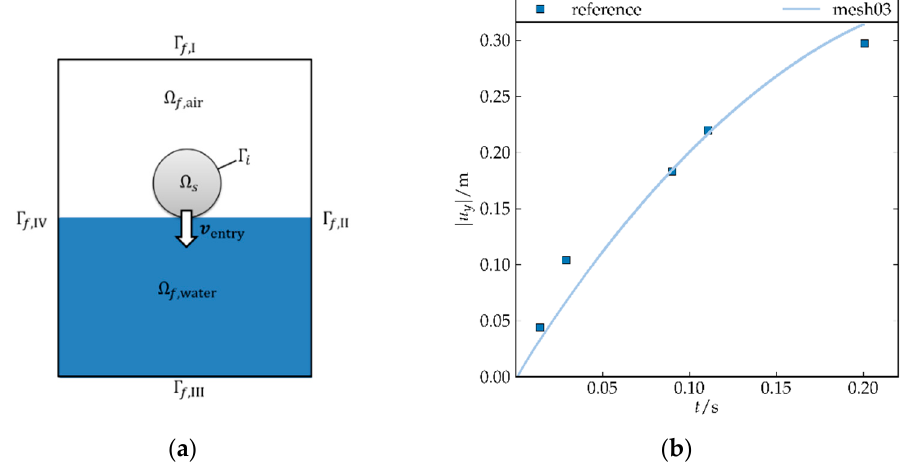
Figure 4. Drop test of rigid cylinder: ( a ) Schematic representation of drop test; ( b ) Results from drop test of rigid cylinder, experimental results from [31] .